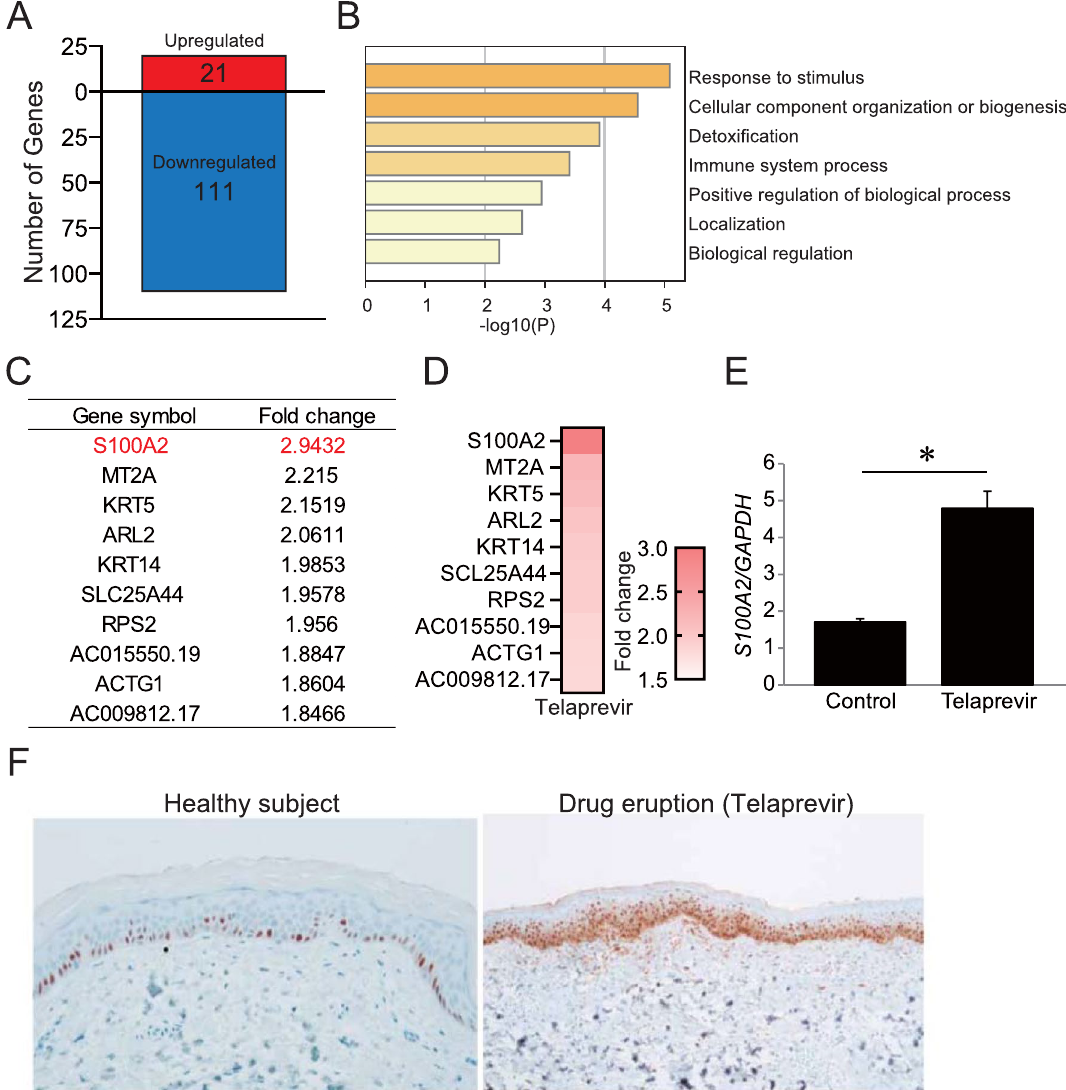
Figure 1. The expression of S100A2 in telaprevir-treated keratinocytes. ( A ) Microarray analysis of the dysregulated genes in keratinocytes after telaprevir treatment. ( B ) GO enrichment analysis of upregulated genes in telaprevir-treated keratinocytes. ( C , D ) The list ( C ) and heat map ( D ) of top 10 upregulated genes in keratinocytes by telaprevir. ( E ) S100A2 gene expression in keratinocytes. ( F ) Immunostaining for S100A2 in the skin. Results are expressed as the mean ± SD. p-values were obtained by the Student’s t -test: *p <